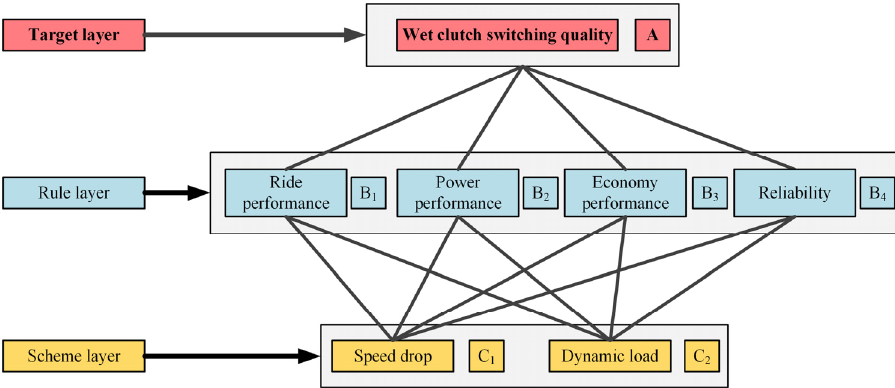
Figure 4. Layers of the wet clutch switching